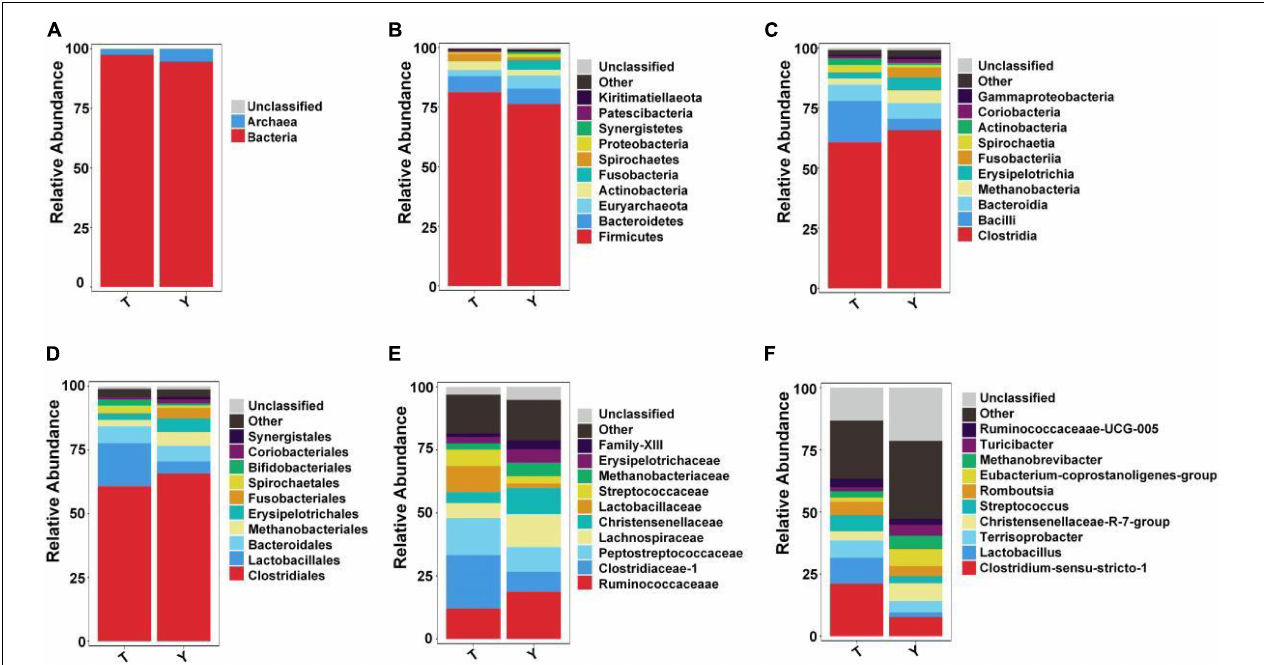
FIGURE 3 | Ten most abundant taxa of intestinal microflora in Tibetan (T) and Yorkshire (Y) pigs at boundary. Relative abundance at the kingdom (A) , phylum (B) , class (C) , order (D) , family (E) , and genus (F)